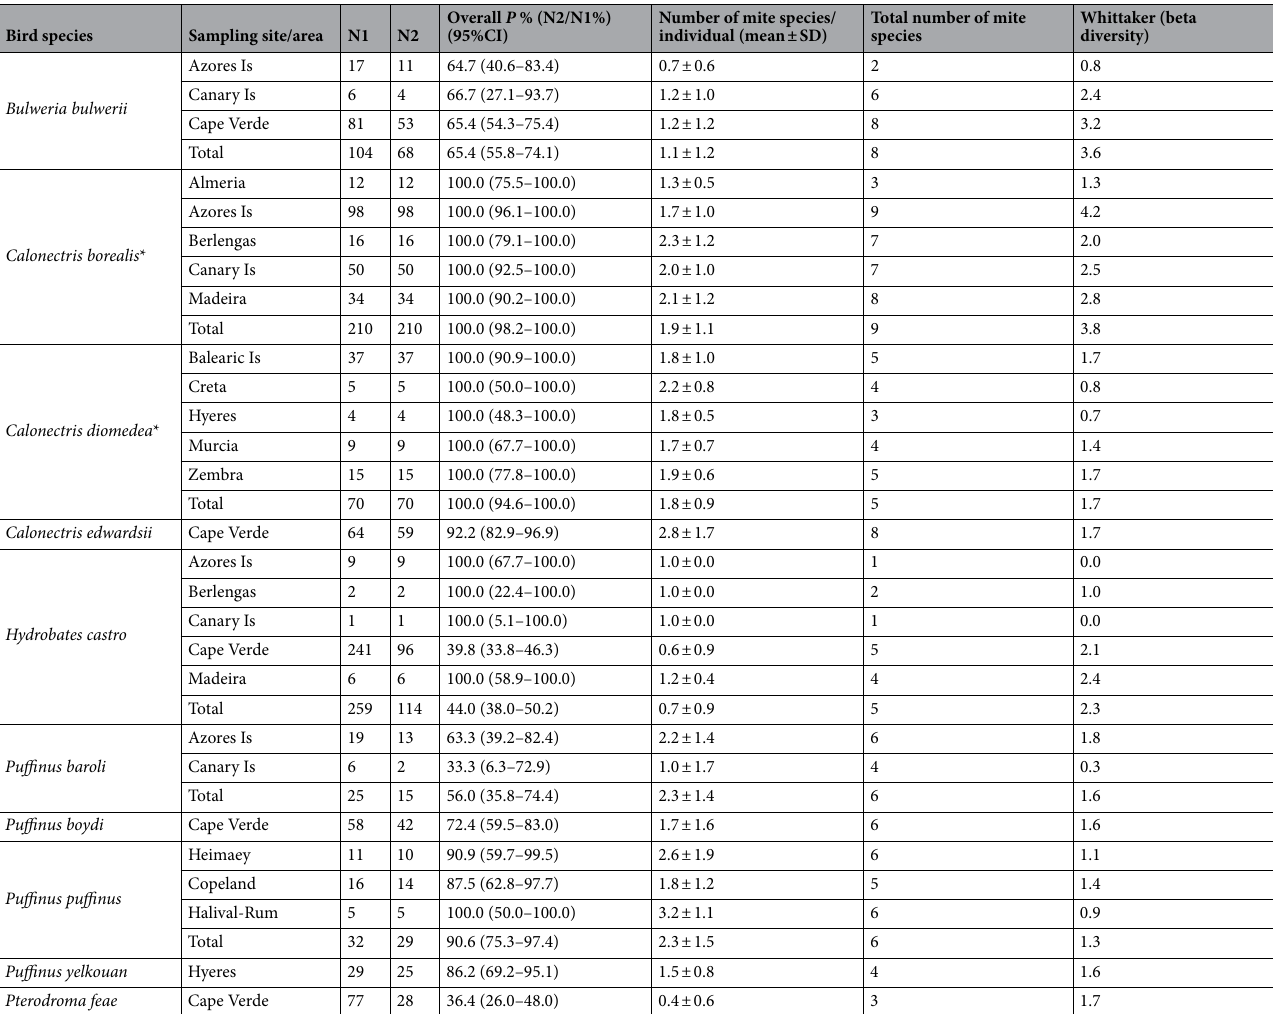
Table 1. The number of feather mite species (prevalence— P %; mean and total species number; estimates for diversity) found on each seabird species and sampling site/area in the north-east Atlantic Ocean and Mediterranean Sea (N1 = number of examined birds, N2 = number of infested birds). The two Calonectris species sampled by visual inspection are marked with *. The 100% prevalence found in both Calonectris species is an artifact due to the sampling method in which only infested feather were collected (see